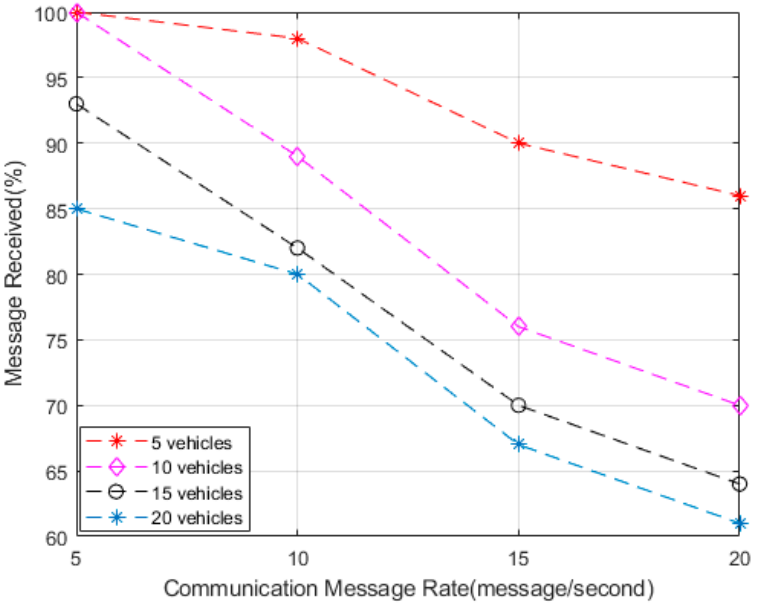
Figure 12. Gateway router-capable node capacity.